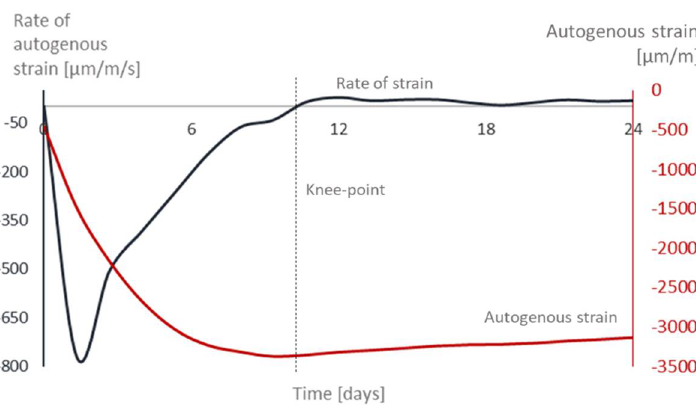
Figure 4. Determining the knee-point of REF0.354.